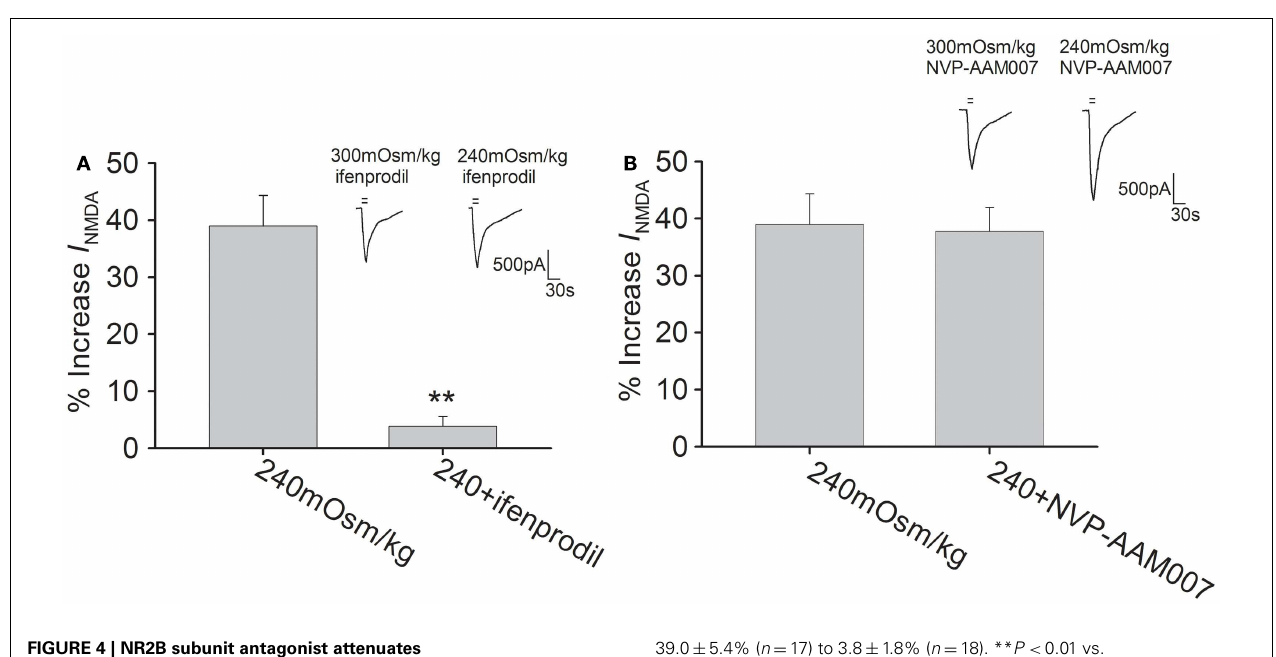
FIGURE 4 | NR2B subunit antagonist attenuates hypotonicity-increased I NMDA . (A) In the presence of ifenprodil, the current was almost not changed by hypotonic stimulation and the increase in I NMDA by hypotonicity was markedly attenuated from